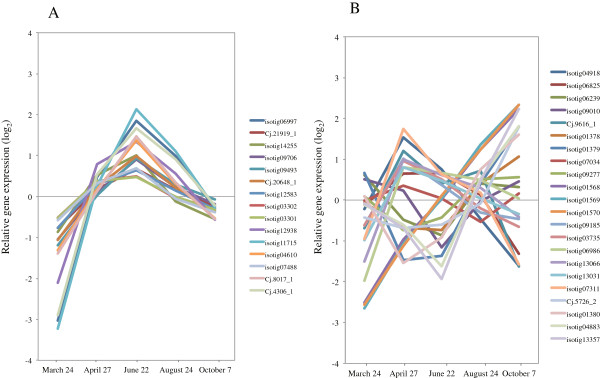
Expression of glycosyltransferase and xyloglucan endotransglycosylase in cambial region during xylem formation. A) Glycosyltransferase. B) Xyloglucan endotransglycosylase. The individual targets are summarized in Additional file 3. All expression data are presented on a log2 scale.